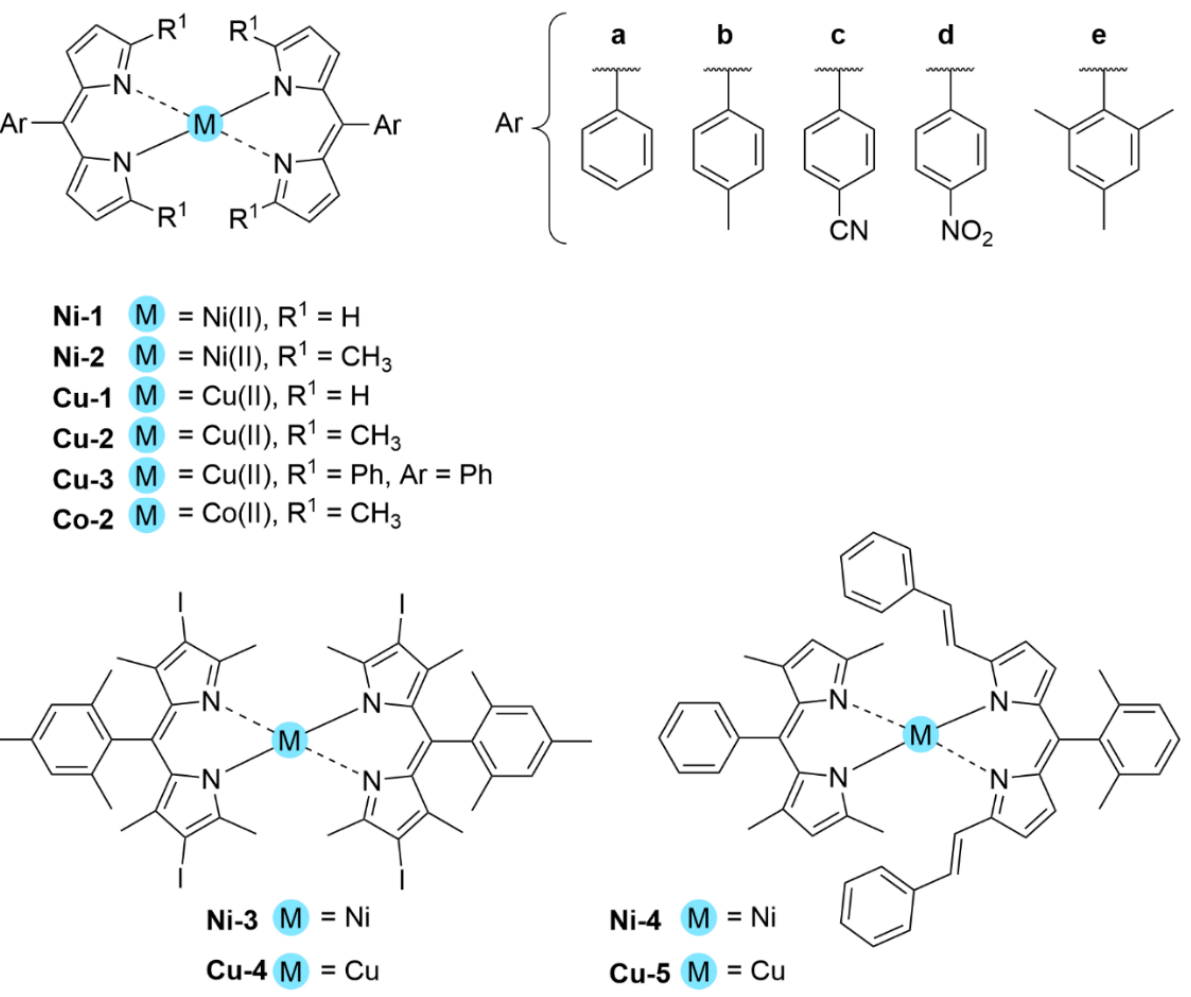
Figure 23. Structures of bis(dipyrrinato)Ni(II) and -Cu(II) and -Co(II) complexes (a = Ph, b = PhMe c = PhCN, d = C 6 H 4 NO 2 , e = Mes).